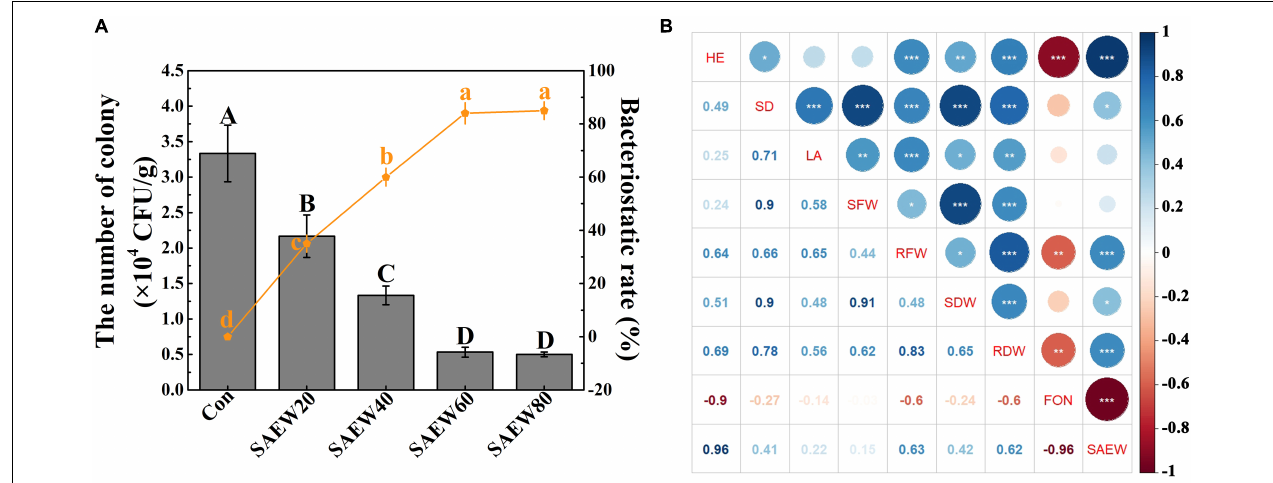
FIGURE 5 | Effects of SAEW on the growth of FON in continuous cropping soil and the correlation analyses of watermelon growth indices, FON, and SAEW application. (A) shows the number of the FON colony and corresponding bacteriostasis rate of different treatments. The correlation between watermelon growth indices, FON, and SAEW application is shown in (B) . The number of the colony (CFU/g) = the mean number of the colony in diluent × dilution ratio/dry weight. Bacteriostasis rate = (the number of the colony in Con-the number of the colony in treated group)/the number of the colony in Con × 100%. Data are means ± SE from three independent experiments. Vertical bars represent the standard deviation (SD) of the mean of 9 biological replicates ( n = 9). Additionally, bars with different lowercase letters are the significant differences between the bacteriostasis rate of Con and it of treated groups at P < 0.05 according to the Duncan’s multiple range test. The correlation analyses were conducted using R language with the watermelon growth indices in Supplementary Figure 2 and the number of FON colonies in soil with treatments of different SAEW concentrations in (A) . The asterisk in (B) reveals the significant differences in correlation. Blue and red indicate the positive and negative correlations, respectively. Data are means ± SE from three independent experiments with 5 biological replicates for each ( n = 15). *, **, and *** represent significant differences at P < 0.05, 0.01, and 0.001, respectively. Con and control (deionized water); SAEW20 (20 ppm concentration of slightly acidic electrolyzed water); SAEW40 (40 ppm concentration of slightly acidic electrolyzed water); SAEW60 (60 ppm concentration of slightly acidic electrolyzed water); SAEW80 (80 ppm concentration of slightly acidic electrolyzed water); FON, Fusarium oxysporum f. sp. niveum ; HE, height; SD, stem diameter; LA, leaf area; SFW, shoot fresh weight; RFW, root fresh weight; SDW, shoot dry weight; RDW, root dry